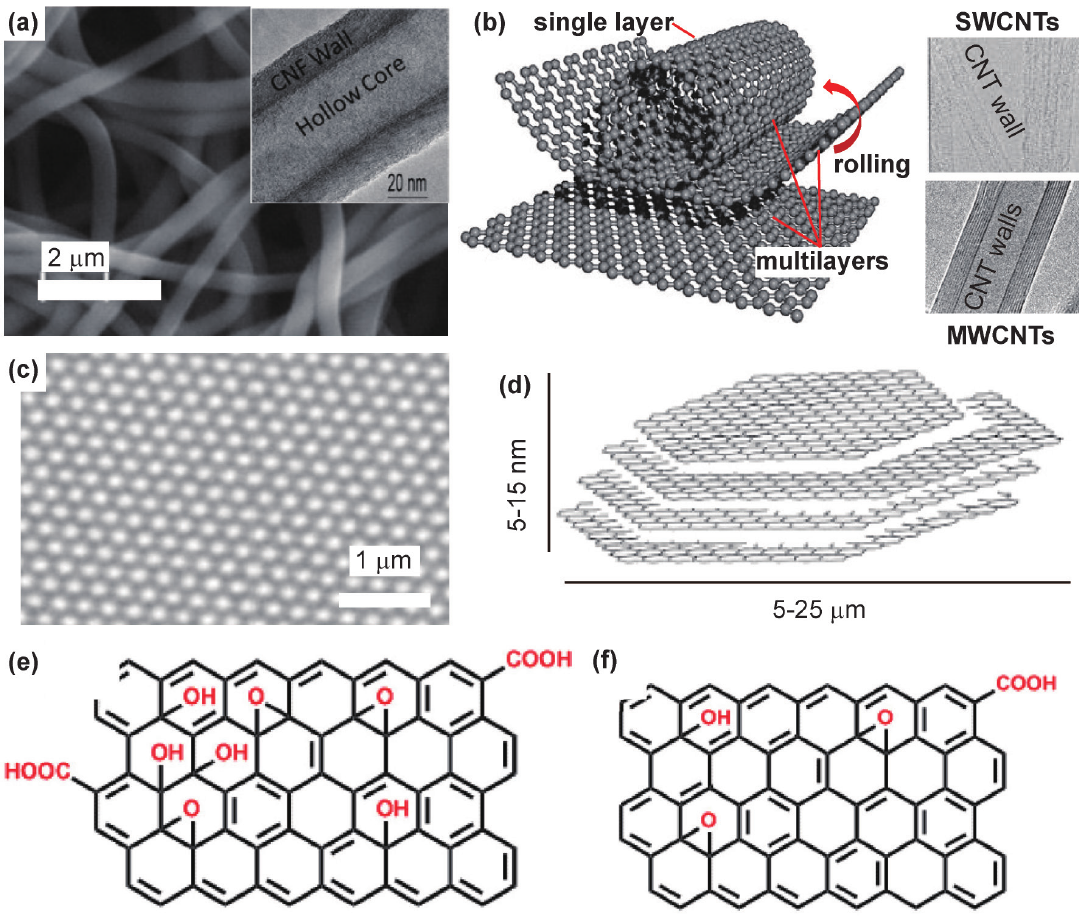
Figure 1: (a) SEM and TEM images of carbon nanofibers (CNFs) [32, 33]; (b) representation and TEM images of carbon nanotubes (CNTs) [34– 36]; (c) morphology of graphene [14]; representations of (d) graphene nanoplates (GNPs); (e) graphene oxide (GO); (f) reduced graphene oxide (rGO)